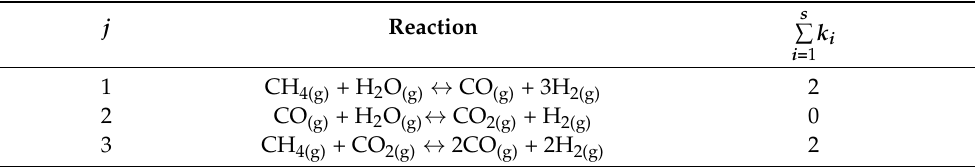
Table 1. Model reactions ( j = 1, 2, 3) in steam reforming of a CH 4 /H 2 system.